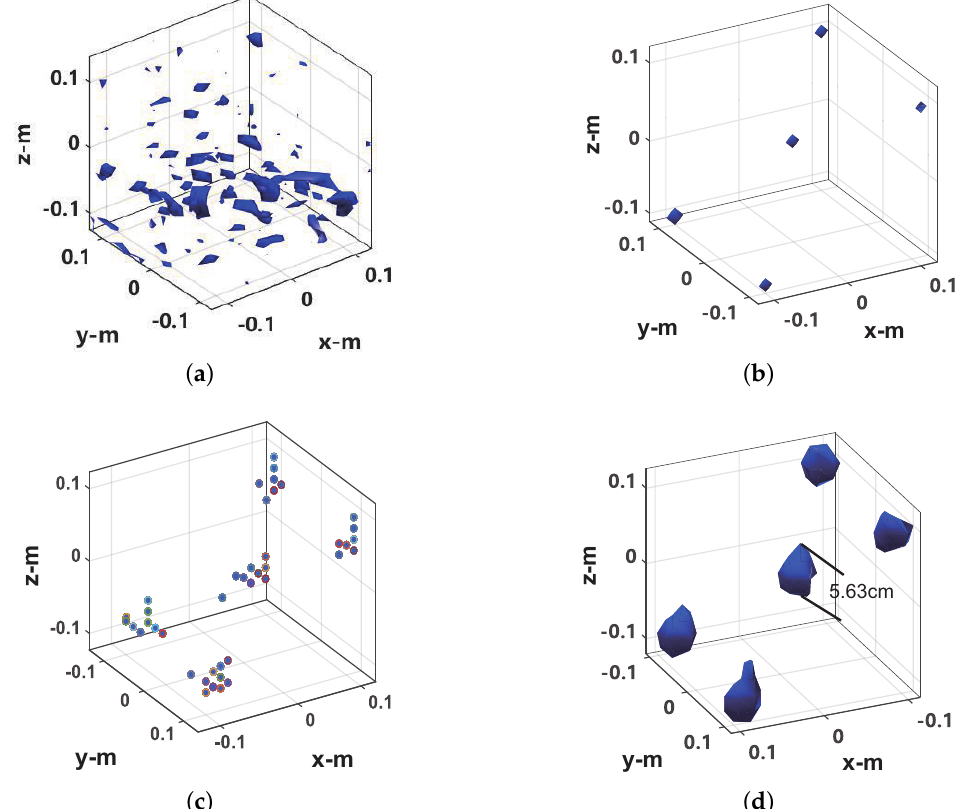
Figure 12. Imaging results from 30% sampled data. ( a ) Frequency interpolation method. ( b ) OMP-CS method. ( c ) (cid:96) 1 -TV-CS method. ( d ) Proposed